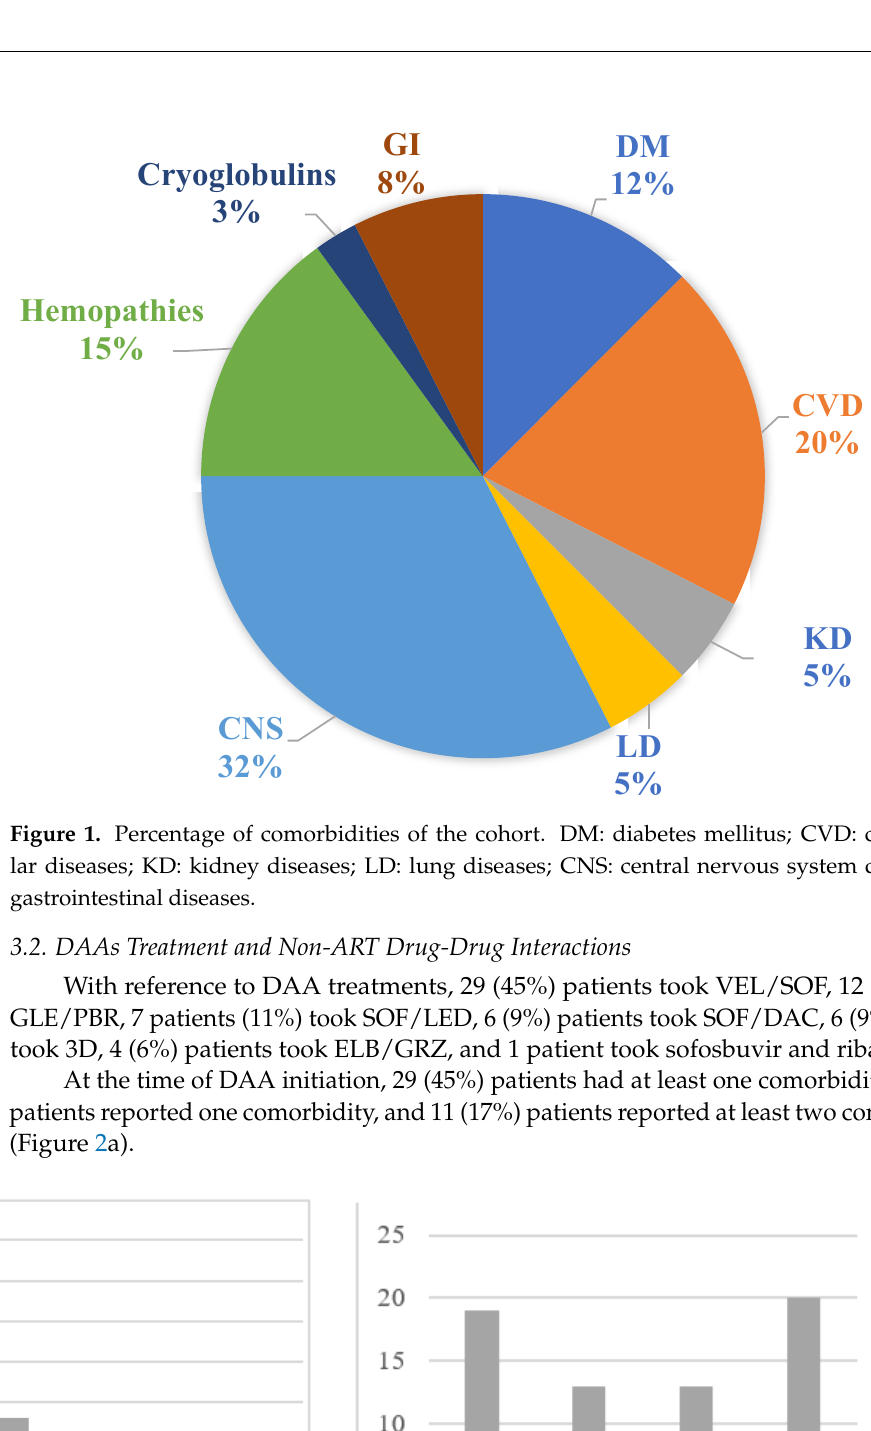
Figure 2. ( a ) Frequency of comorbidities (CMB) in the cohort of patients. ( b ) Frequency of number of drugs regularly assumed by HCV/HIV co-infected patients (ART not included).